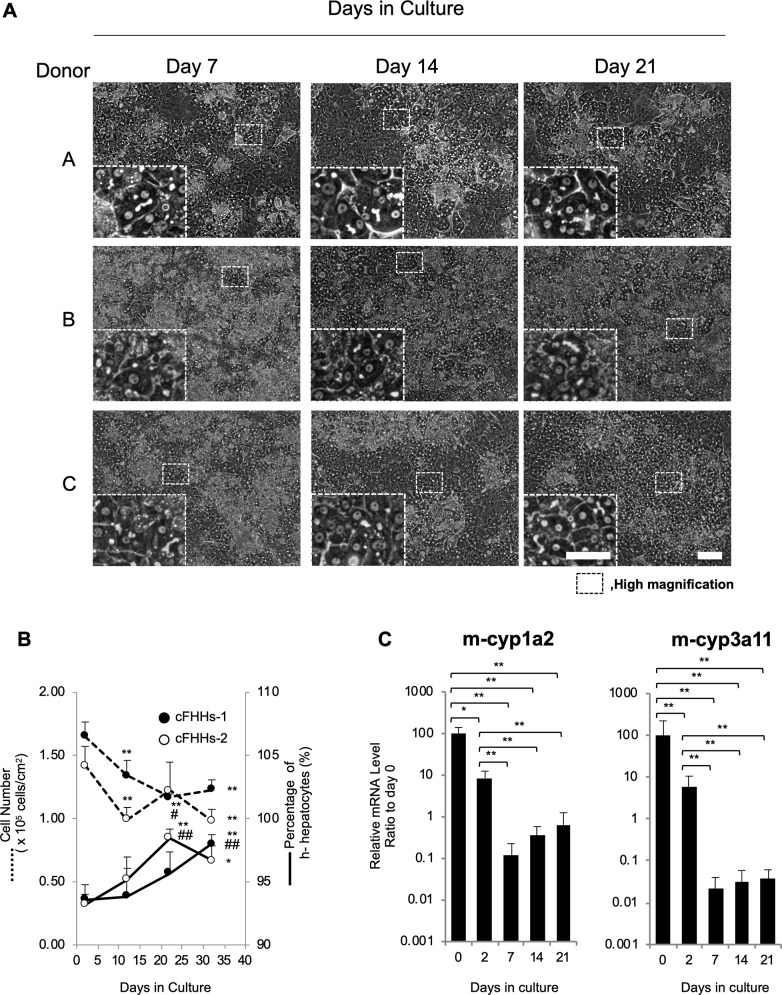
Morphology, viability, and purity of cFHHs during culture.A: Phase contrast microphotographs of cFHHs during culture at day 7, 14 and 21. cFHHs isolated from chimeric mice transplanted with three different donor cells (Donor A, B, and C) were plated at 2.13 x 105 cells/cm2 and cultured. The inserts are high magnification images. Scale bars denote 100 μm in the low magnification images and 50 μm in the high magnification images. B: Cell numbers and ratio of h-hepatocytes during culture. cFHHs isolated from two different chimeric mice transplanted with donor A cells were plated (2.13×105 cells/cm2) and fixed at days 2, 13, 23, and 33. After Hoechst staining, h-hepatocytes and mouse cells were counted by microscopic observation of three to five fields. Total cell numbers and percentages of h-hepatocytes are denoted by dotted and normal lines, respectively. C: Mouse gene expression levels during culture. Expression levels of m-cyp1a2 and 3a11 mRNA were measured by qPCR on days 0, 2, 7, 14, and 21. Data are expressed as mean ± SD. *p<0.05 versus at day 2; **p<0.01 versus at day 2; #p<0.05 versus at day 12; ##p<0.01 versus at day 12.